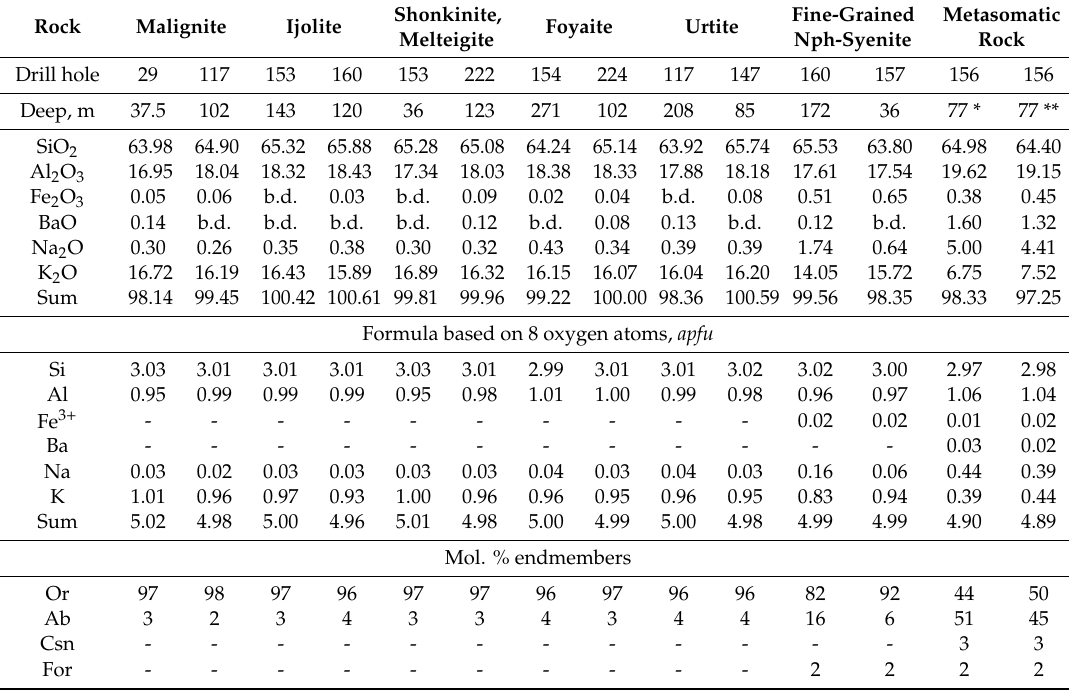
Table 1. Representative microprobe analyses of alkali feldspar, wt.